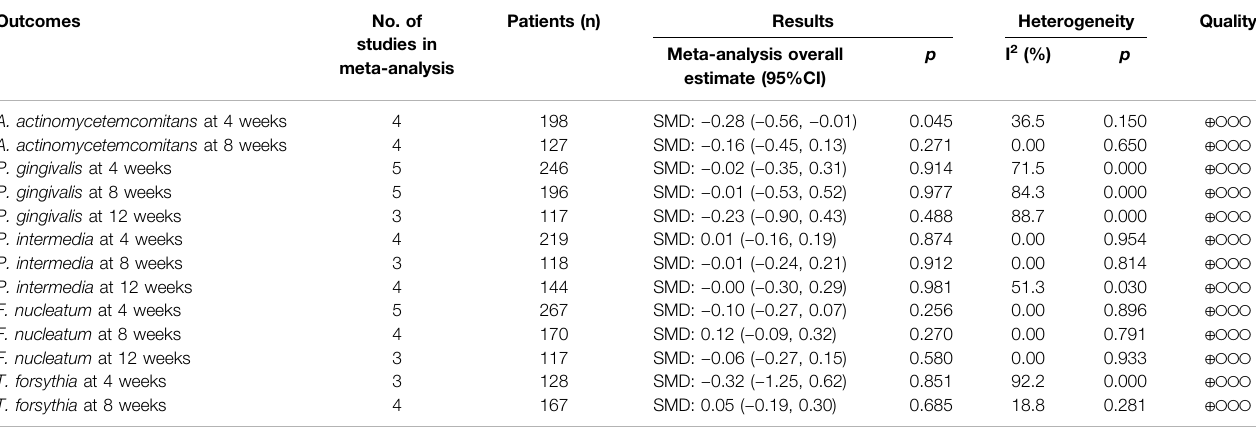
TABLE 1 | Summary of s tatistical analysis for the microbiological